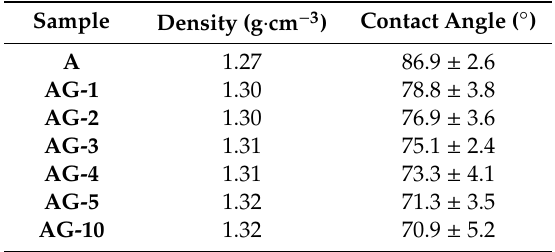
Table 6. The densities and contact angles of the prepared virgin PETG composite materials with the EG. EG.